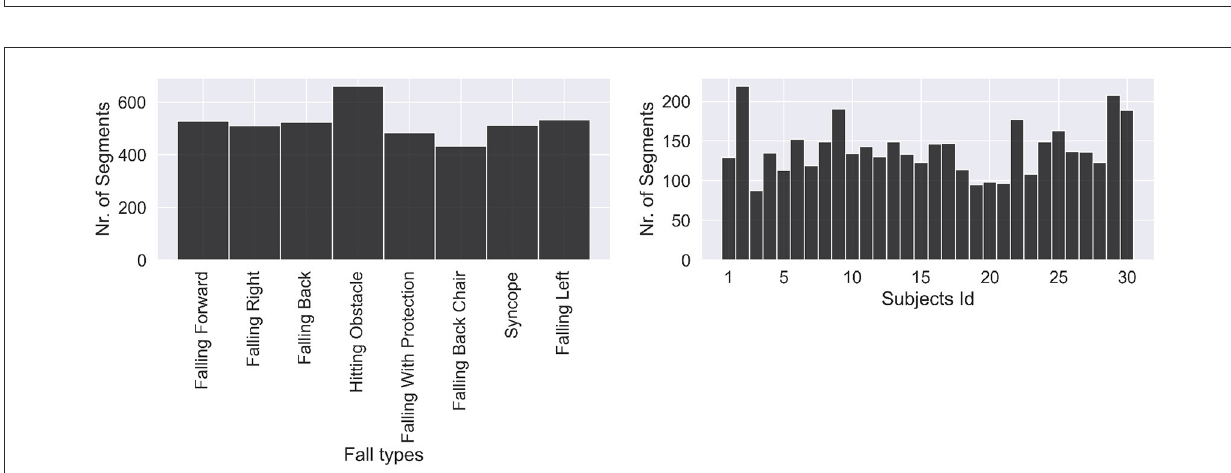
FIGURE3 Distribution of fall activities. Classes are fairly balanced as all falls are about equivalent to